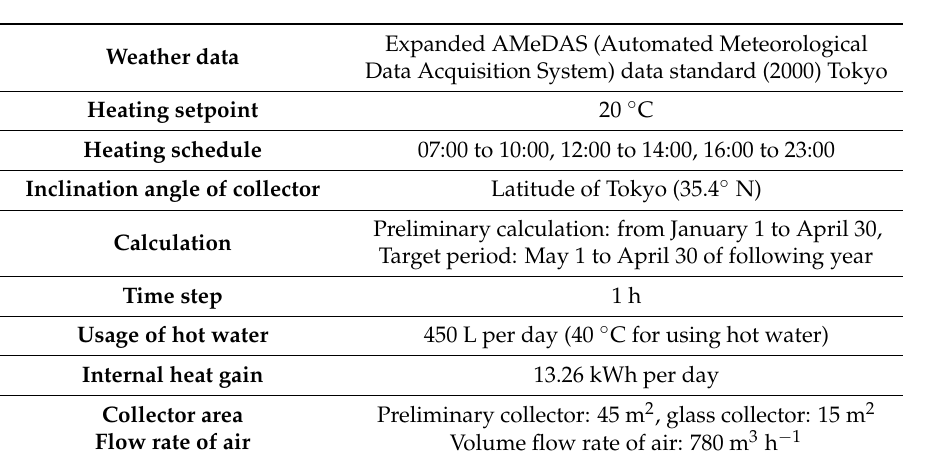
Table 2. Simulation conditions.